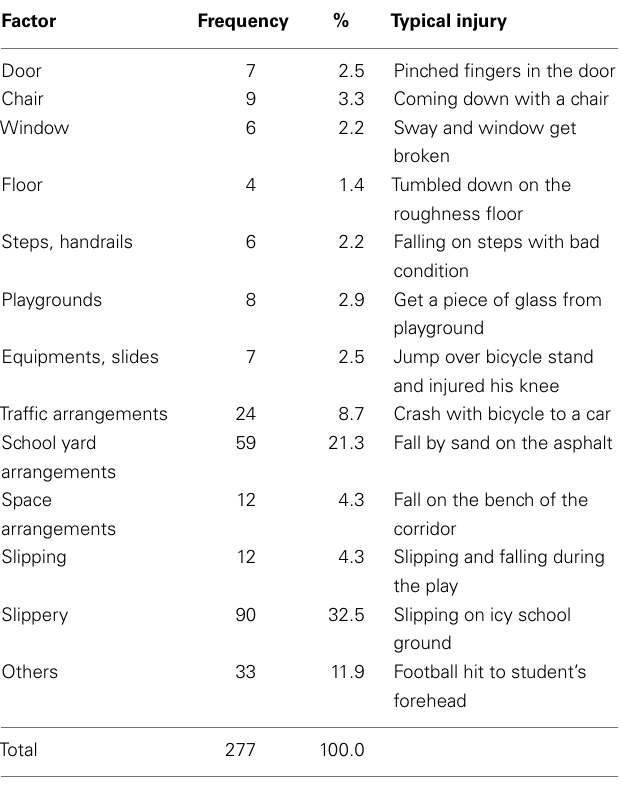
Table 1 | Environmental factors related to school injuries .